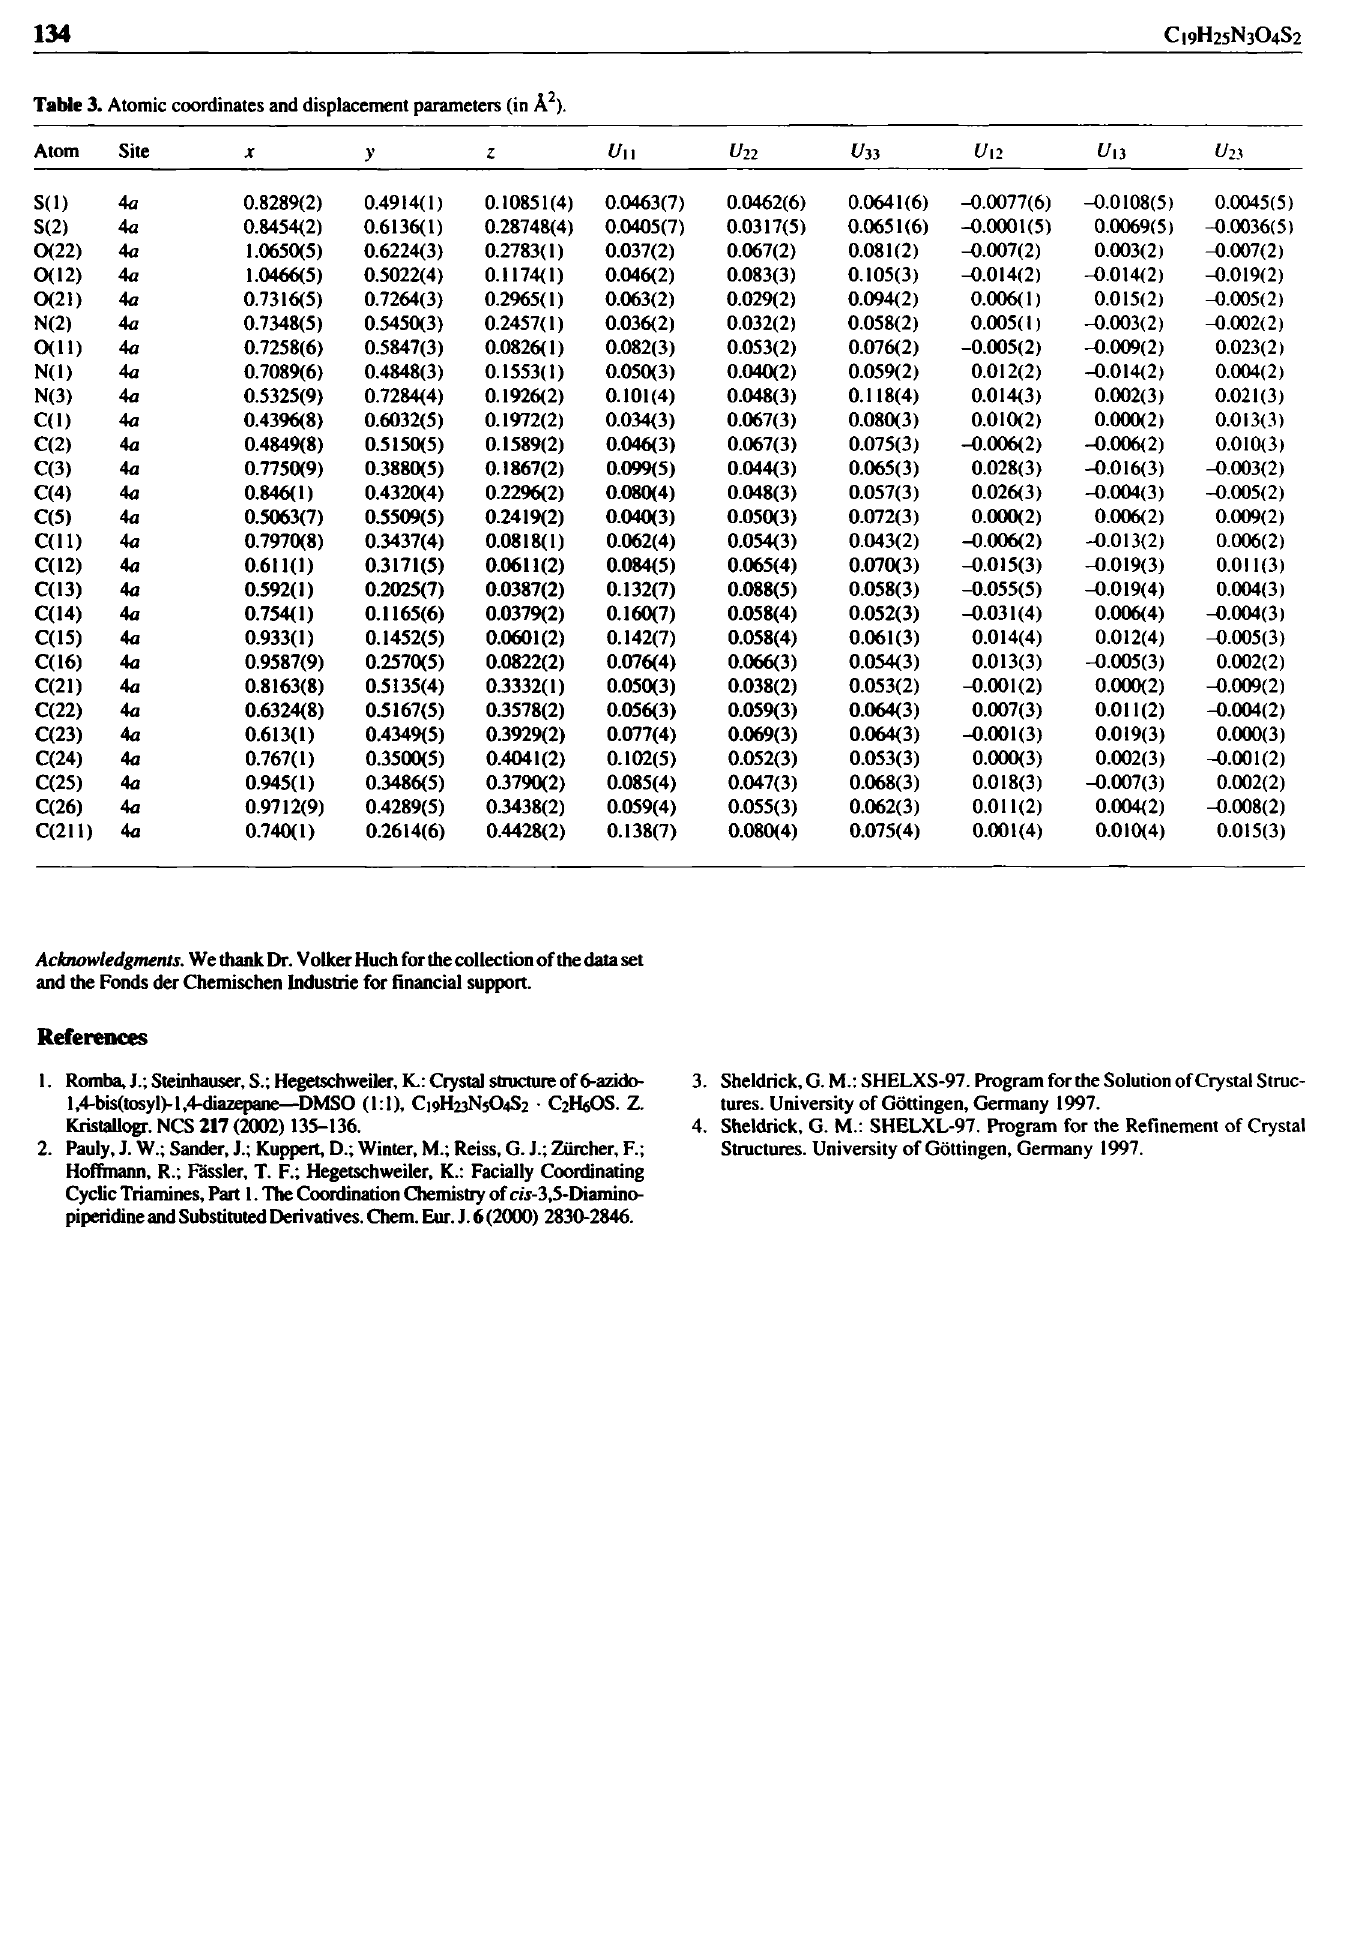
Table 3. Atomic coordinates and displacement parameters (in Â 2